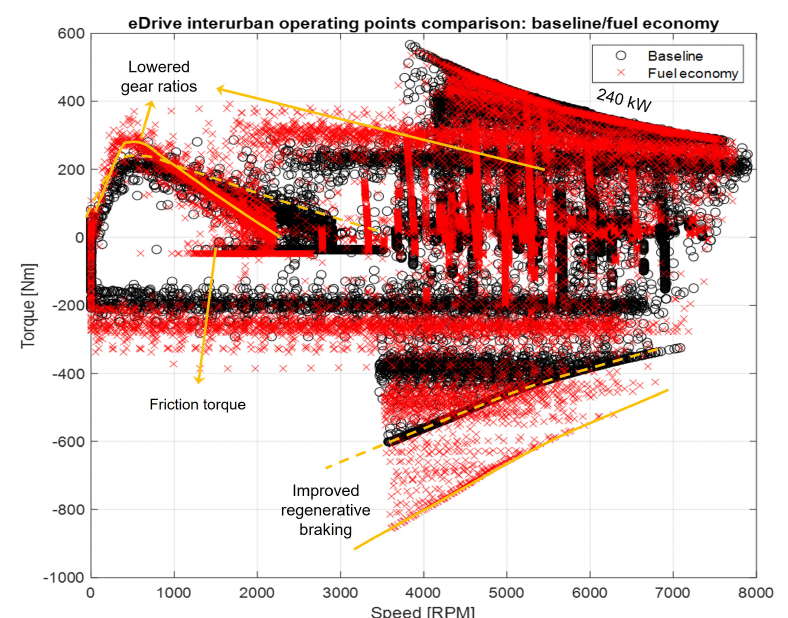
Figure 13. Comparison of eDrive operating points for the smallest and largest sizing solutions (baseline and fuel economy-focused). Shift along torque axis (vertical) can be linked to eDrive sizing as well as gear ratio optimisation, whereas shift along speed axis (horizontal) is related to only gear ratio optimisation whose constraints are relaxed for larger eDrive